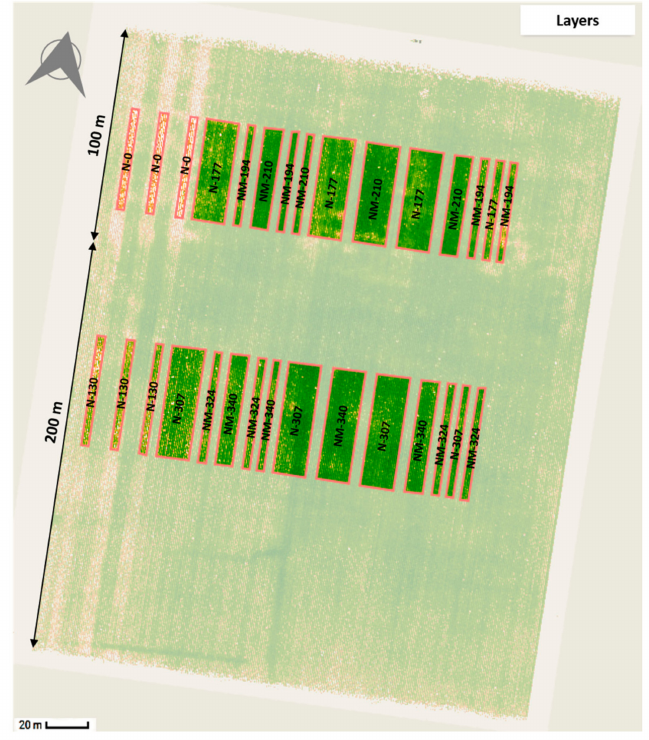
Figure 2. Normalized difference red edge (NDRE) map for the fourth measurement date, 9 February 2016 (118 days after sowing), showing the distribution of the eight N rate treatments across the paddock and the masks used to extract the spectral information in each